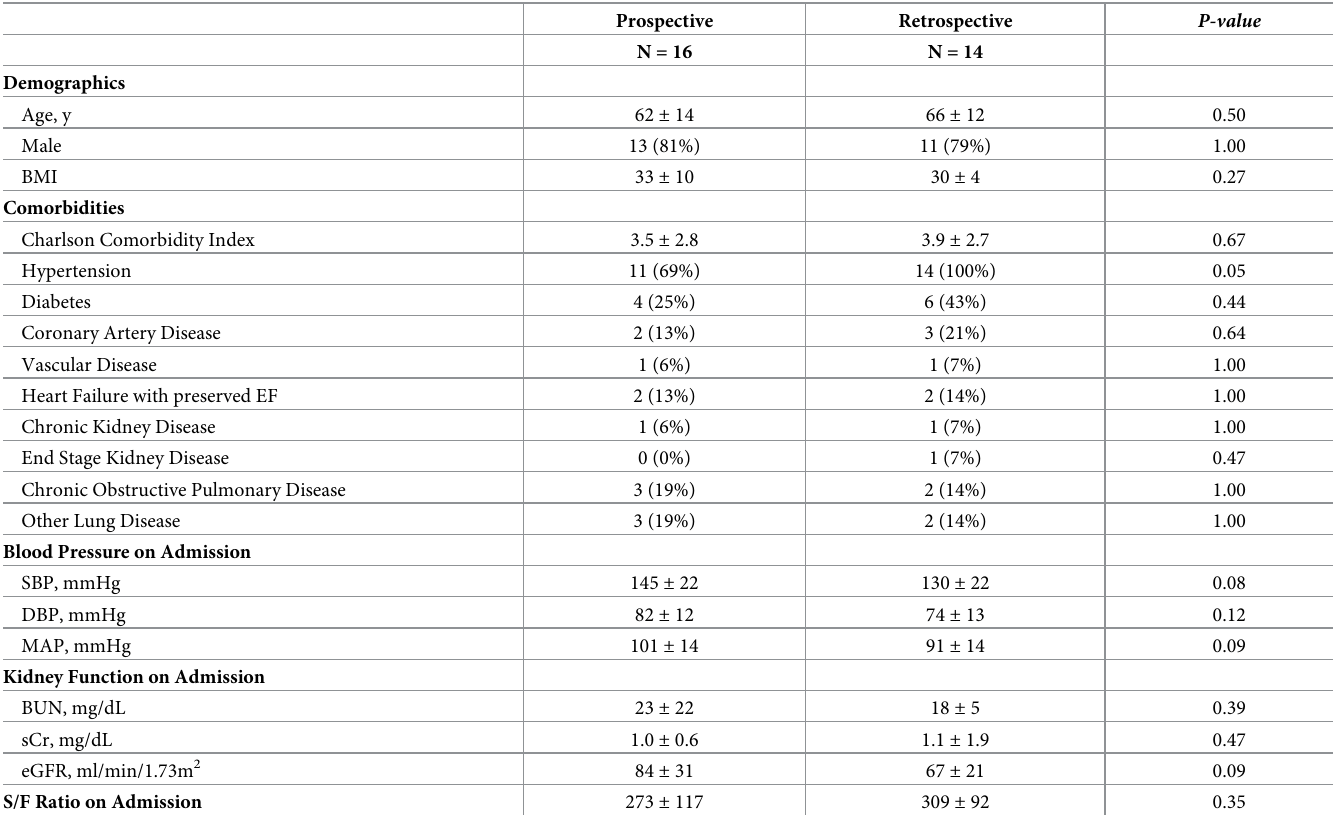
Table 1. Presenting characteristics in the study